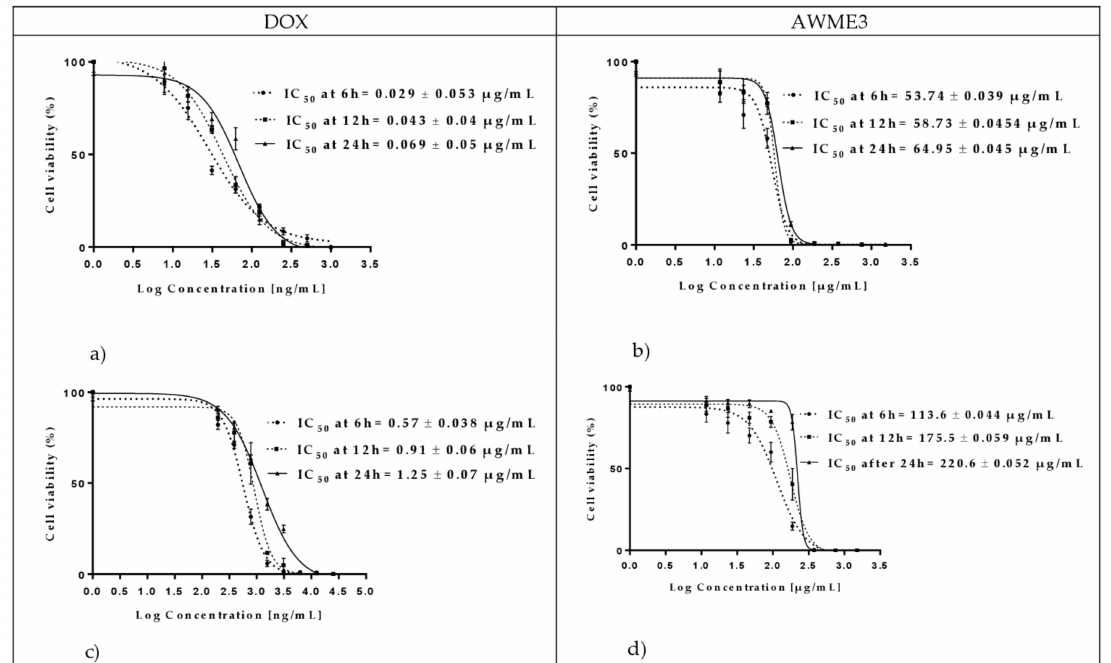
Figure 6. The MIC 50 of fish pathogenic bacteria treated with AWME3 from the larvae fat in comparison with the Doxicycline (control antibiotic). The MIC50 was determined based on the turbidimetric assay data and compared to the positive control doxycycline (DOX). The pathogenic cells turbidity assessed at 6 h, 12 h, and 24 h of incubation. A. hydrophila treated with ( a ) doxycycline (DOX) and ( b ) AWME3; A. salmonicida treated with ( c ) doxycycline (DOX) and ( d ) AWME3. MIC 50 values calculated by using a non-linear regression mode of Graph pad Prism7 software. Presented values are the mean ± standard error of the mean. The IC 50 (MIC 50 ) values as an average of three independent experiments ± standard deviation error mean (SEM) presented in Table